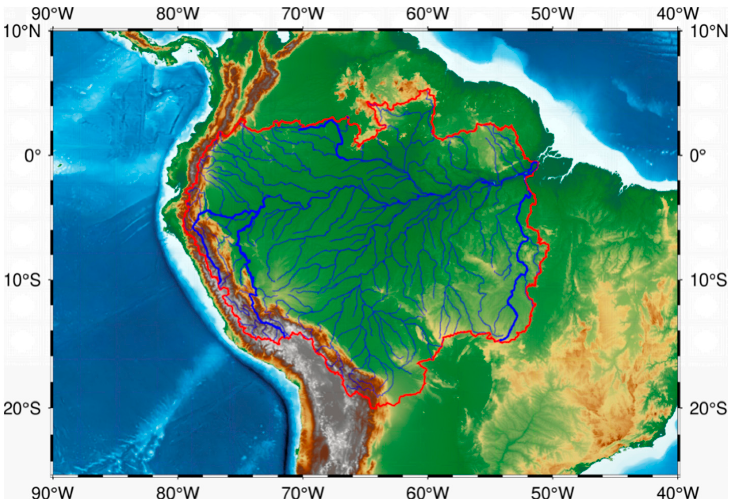
Figure 1. Amazon River basin (the red curve is the basin boundary and the bold line is the main